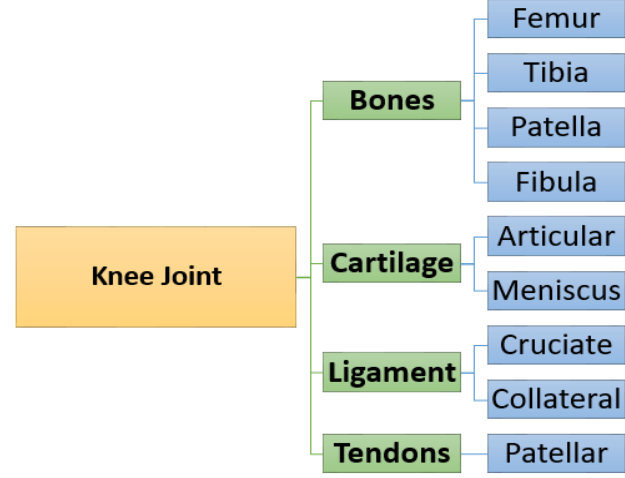
Figure 1. Taxonomy of knee joint anatomy.